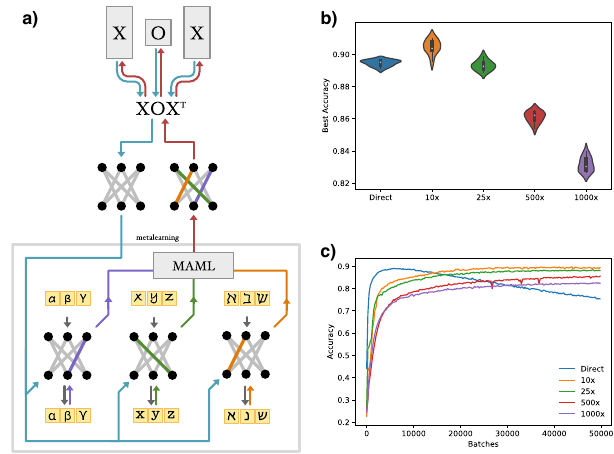
Fig. 3 | Meta-Learning with GEM. a Visualization of the Omniglot meta-learning pipeline.Intheouterloop(top)theGEMgeneratesaninitialnetwork,whichisused for all tasks in the inner loop ( “ metalearning, ” bottom). For each classi fi cation task (Greek, Latin and Hebrew alphabets) a small number of training steps leads to diverging updates (blue, green and orange weights, respectively). The MAML algorithm allows for a meta-gradient (red arrows) to be passed back to X and O in the outer loop, thereby generating a network better suited to all tasks in the next iteration. b Violinplotsofthebesttestaccuracyforvariousmodels( n =10runsper model, showing median and quartile range). In order of performance, a 10x GEM achieves 90.5±0.4% accuracy, a standard MLP (Direct) achieves 89.5±0.2%, a 25x GEM achieves 89.3±0.3%, a 500x S-GEM achieves 86.1±0.3%, and a 1000x S-GEM achieves 83.2±0.4% accuracy. c Average accuracy of the models over 50,000 training batches ( n =10 runs, bands show 95% con fi dence interval). Although the standard MLP achieves peak performance in fewer batches, it over fi ts the training data, decaying in accuracy with further batches. In contrast, both the GEM (10x, 25x) and the S-GEM (500x, 1000x) compressions achieve peak performance later, but do not suffer over fi